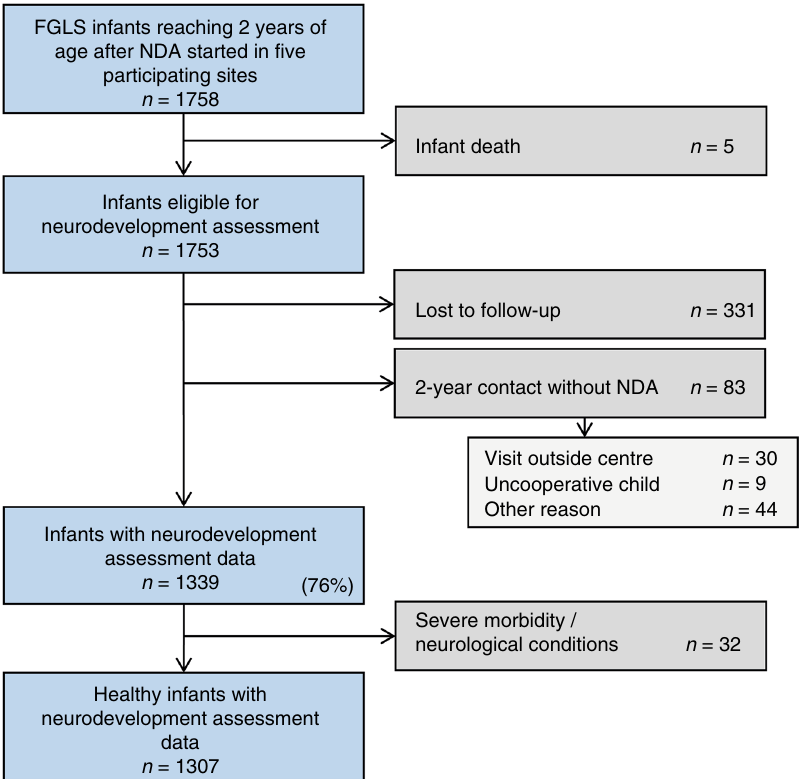
Fig. 1 Participant fl ow: INTERGROWTH-21 st Project Neurodevelopment Assessment cohort at 2 years of age